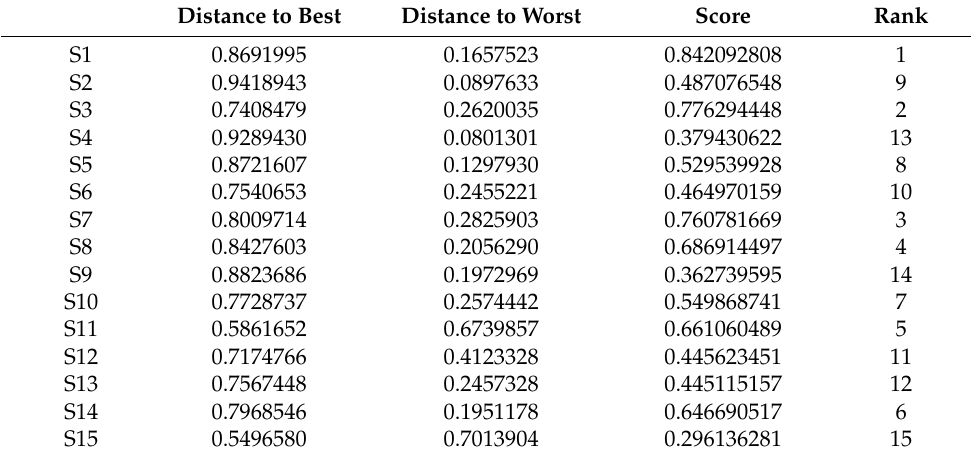
Table 4. Score ranking of different swimmers based on the improved distance method (unit: null). Distance to